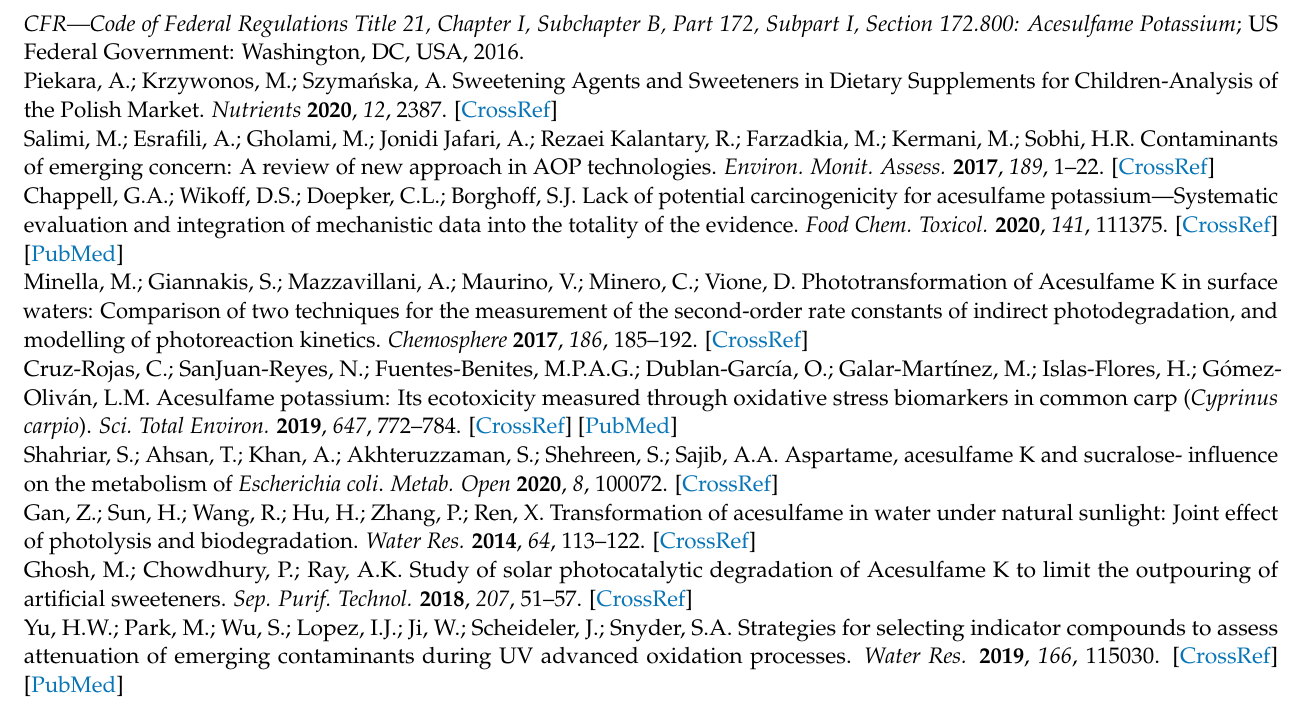
Figure S2: Thermal stability tests—thermogravimetric curves of pure and nitrogen-doped TiO 2 , Figure S3: 100 ppm Acesulfame K photodegradation process in the presence of 5N_TiO 2 catalyst. Variation in absorbance over time, Figure S4: Calibration curve for the nitrogen content determination with the use of